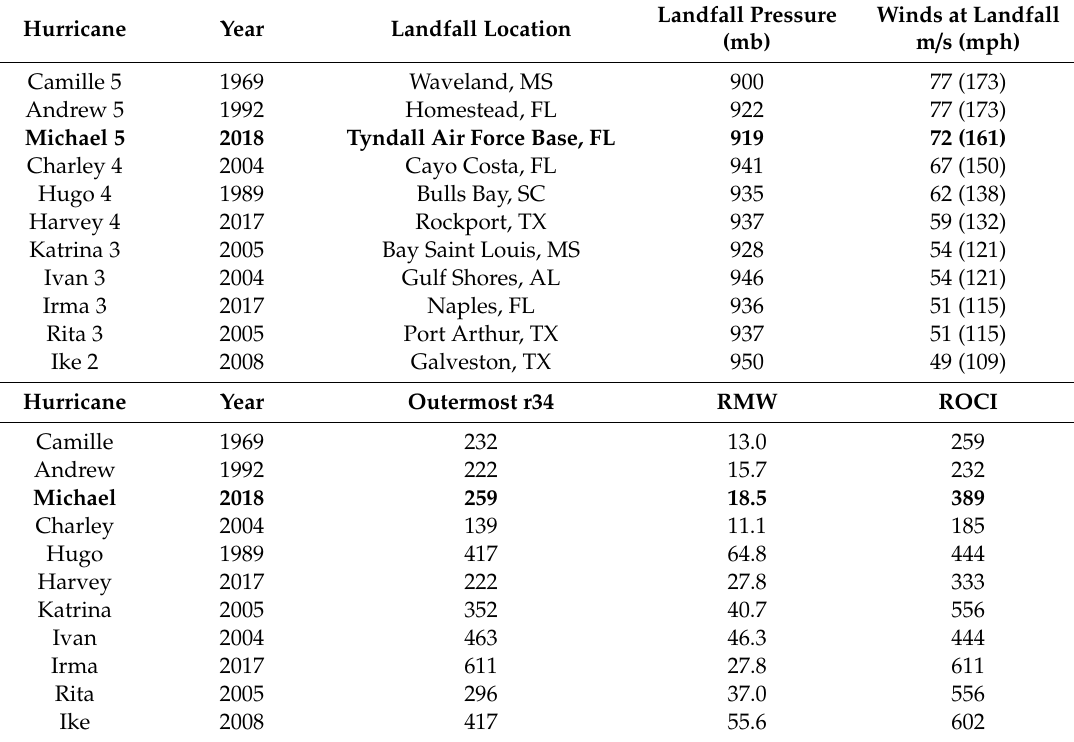
Table 1. Size and intensity characteristics of notable landfalling USA hurricanes. The SSHWS category at landfall is the number next to each hurricane name. Hurricane Michael is in bold. Outermost r34, radius of maximum winds (RMW), and radial distance to the outermost closed isobar (ROCI) are in kilometers. Data compiled from